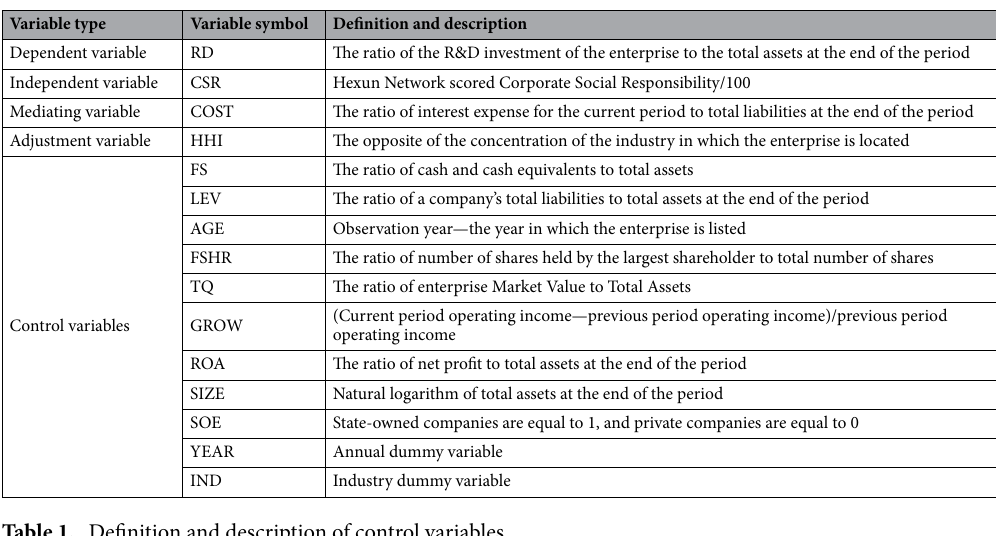
Table 1. Definition and description of control